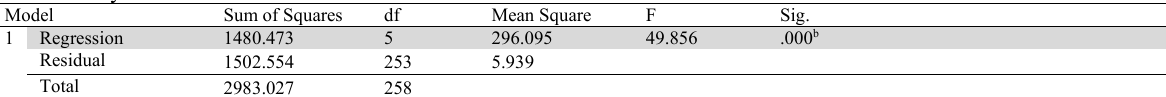
The summary of the results of ANOVA test Model